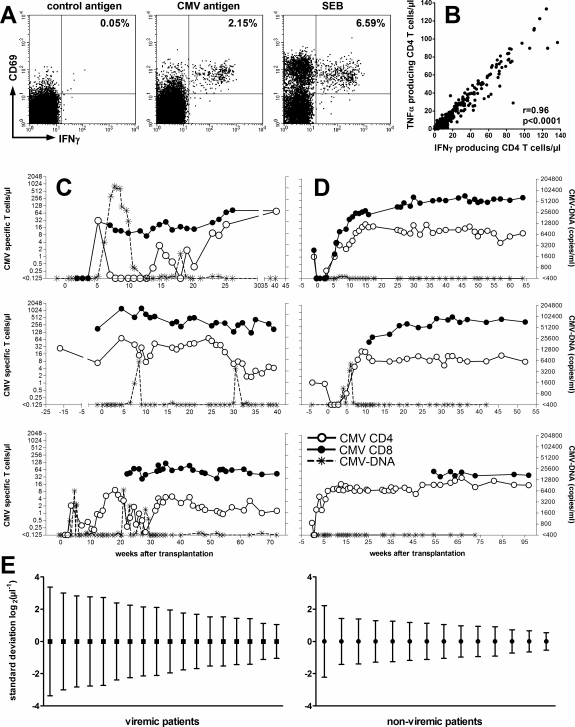
Dynamic changes of CMV specific CD4 T-cell frequencies in viremic patients.A Dotplots showing CMV specific CD4 T cells of a stem-cell transplant recipient, that were quantified by the induction of CD69 and IFN-γ after specific stimulation with CMV antigen (lysate derived from infected fibroblasts). Lysates from non-infected fibroblasts (control antigen) or Staphylococcus aureus enterotoxin B (SEB) served as negative and positive controls, respectively. B There was a significant correlation between the numbers of CMV specific CD4 T cells producing IFN-γ and TNF-α. Representative examples of CMV specific CD4 T cells (white circles), viral load (stars), and CMV specific CD8 T cells (black circles) over time in patients being C viremic and D non-viremic after initial CMV specific T-cell immunoreconstitution. The number of CMV specific CD8 T cells was calculated by adding T-cell levels towards individual MHC class I pentamers (between 1 and 4 per patient). E Higher standard deviations of normalized mean CMV specific CD4 T cell numbers over time in viremic patients (left panel) as compared to non-viremic patients (right panel, p<0.0001). Normalization was performed using the logarithmic values of CMV specific CD4 T cells/µl. Each symbol represents the variation in CMV specific CD4 T cells of one patient over time. Shown are all individuals where at least four samples were available over time (4-41 in viremic and 4-49 in non-viremic patients, respectively).